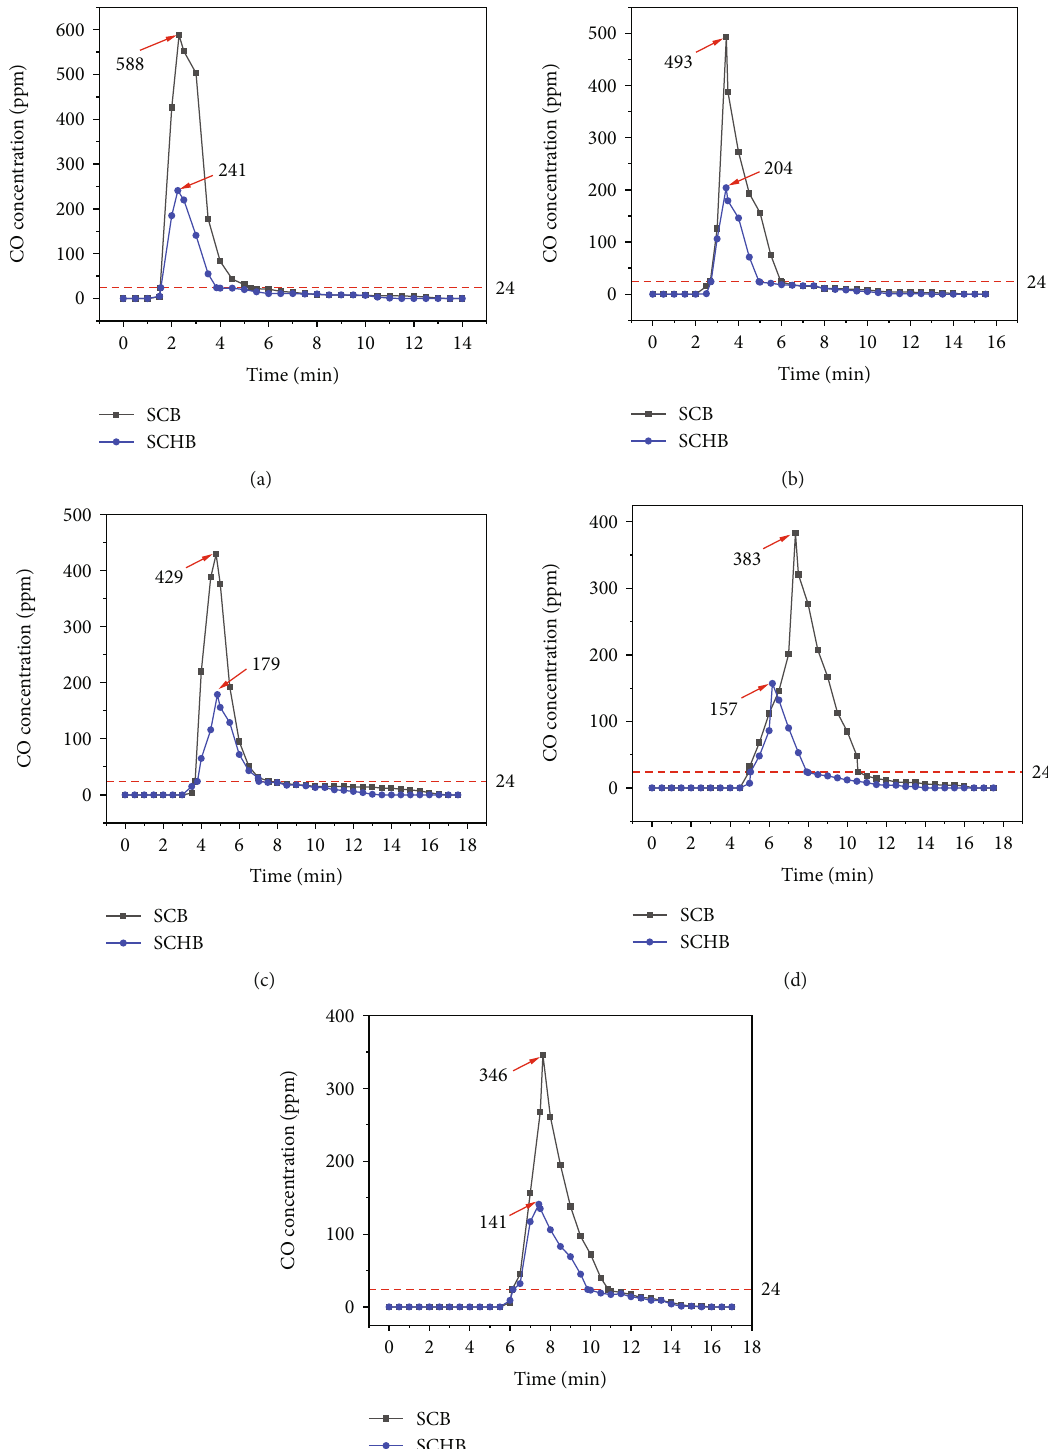
Figure 18: Time-varying curve of CO concentration in four-hole blasting at di ff erent measuring points: (a) 100m from blasting zone, (b) 200m from blasting zone, (c) 300 m from blasting zone, (d) 400m from blasting zone, and (f) 500m from blasting